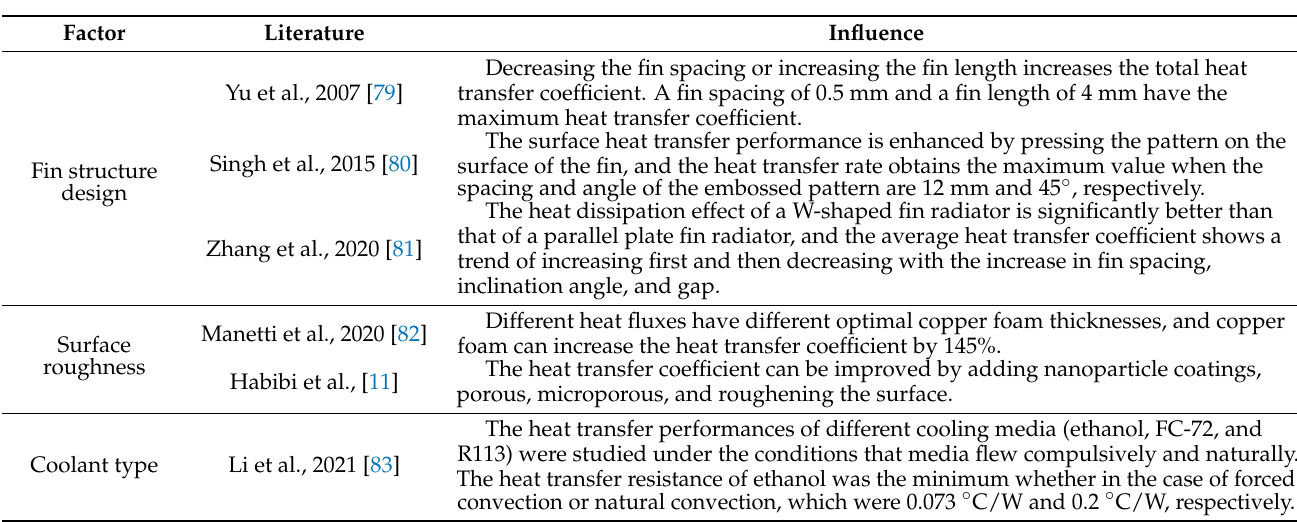
Table 4. Influences of factors on the refrigeration effect of two-phase immersion cooling.